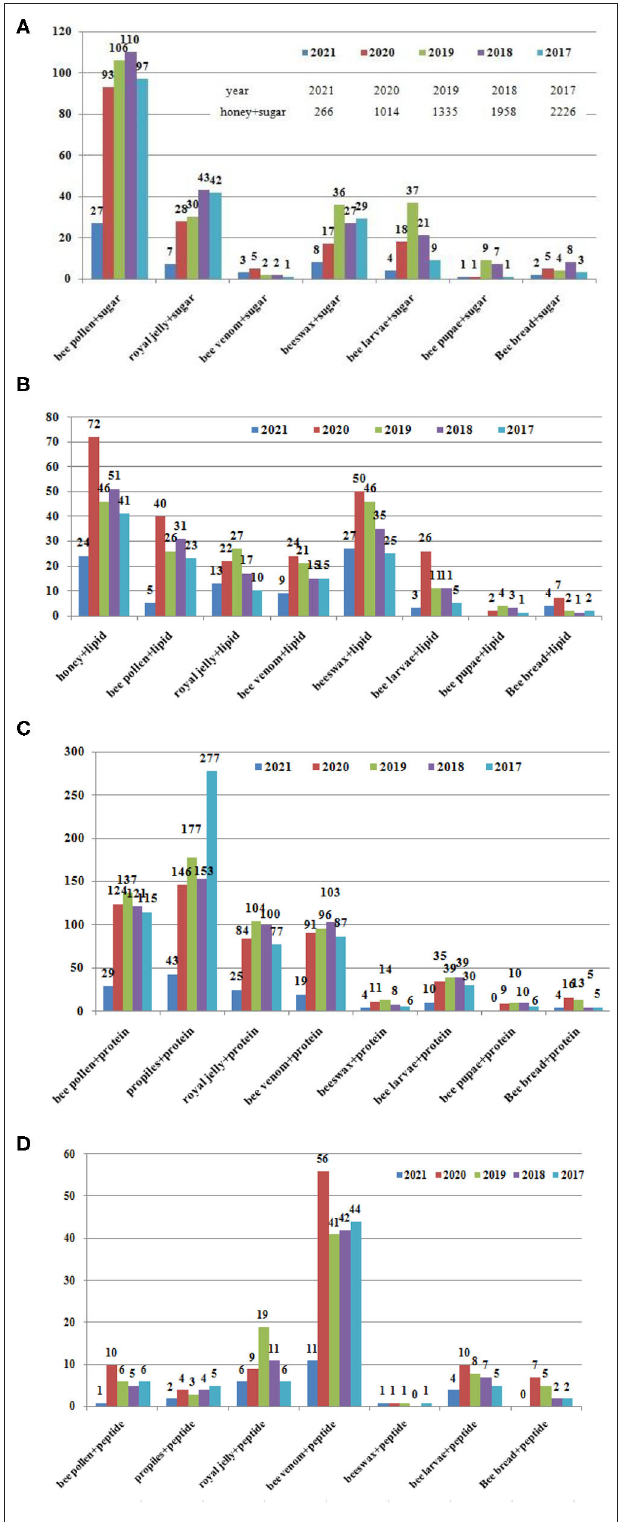
FIGURE 2 | Papers related to bee products published in the recent 5 years (2017–2021). Data from the Web of Science on 4.25. (A) Sugar, (B) lipid, (C) protein, and (D)